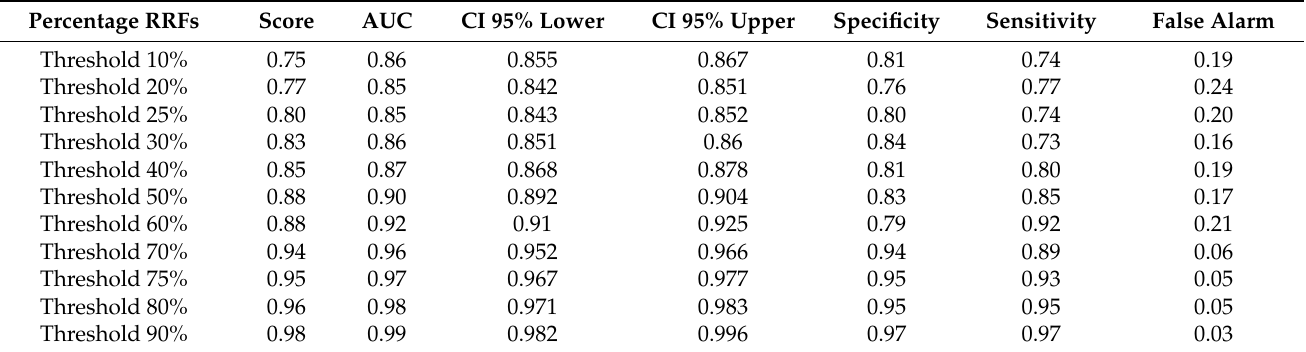
Figure 3. Variable importance of the regression random forest model. Table 1. Performance of the score threshold for the identification of different HRFs reproducibility thresholds.